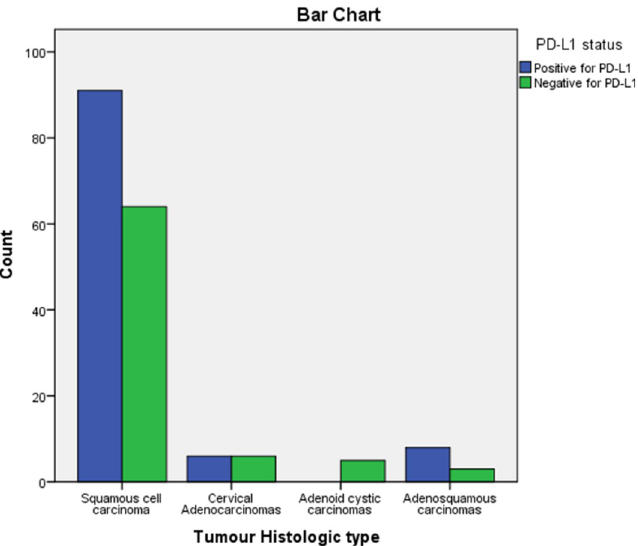
Fig 5. Bar chart showing the correlation between the PD-L1 status and histological types of cervical carcinoma.